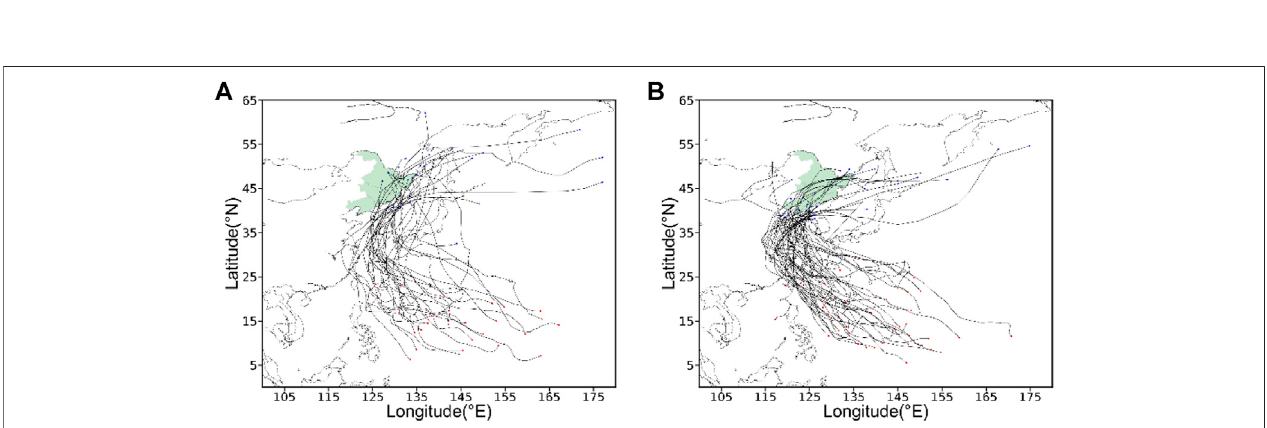
FIGURE 4 | Classi fi cation of the tracks of TCs in fl uencing NEC. (A) Eastern-track type TCs; (B) turning type TCs. The red (blue) dots represent the genesis (dissipation) locations of TCs.